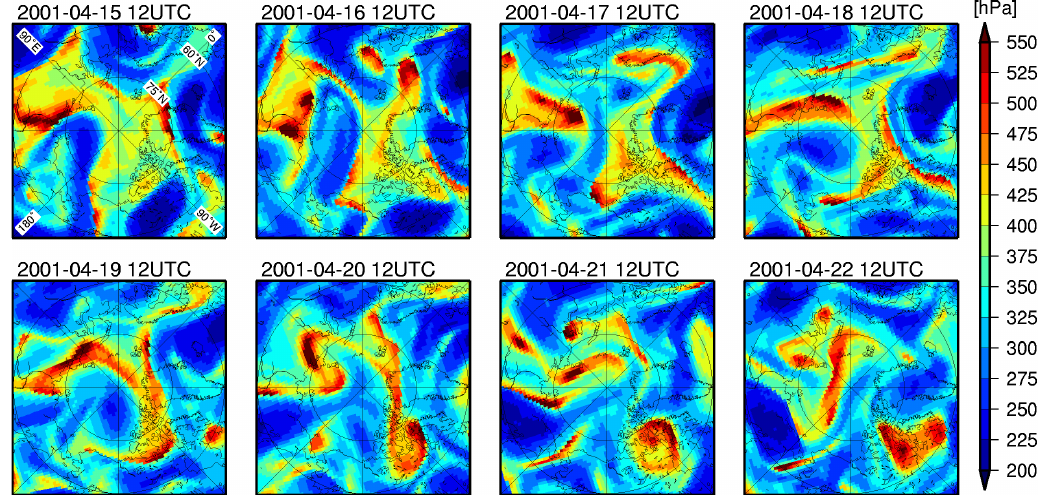
Fig. 11. Dynamical tropopause pressure levels (in hPa) defined by the 2PVU surface at 12:00UTC for each day between 15–22 April 2001 simulated by the GEM